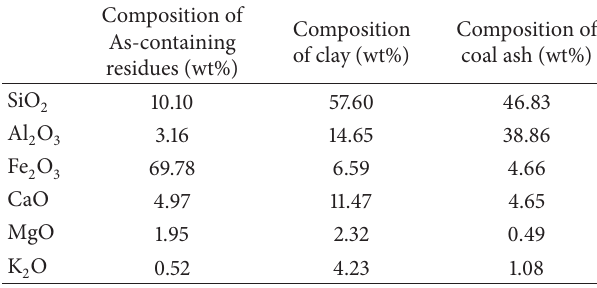
Table 1: Chemical composition of experimental materials.